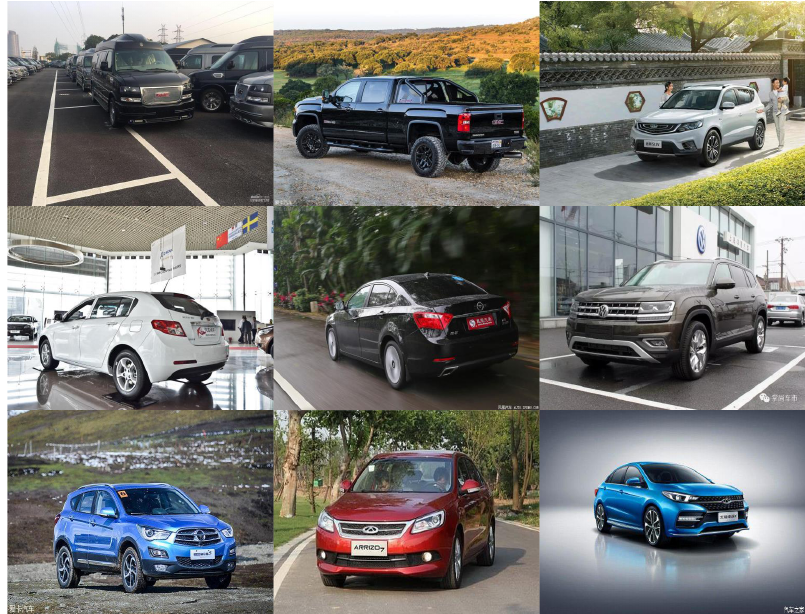
Figure 8. Examples from the dataset.